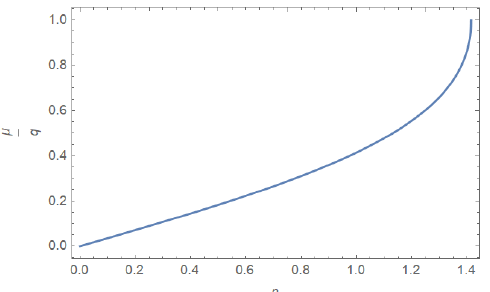
) . Below the line, superradiant scattering with appropriate q